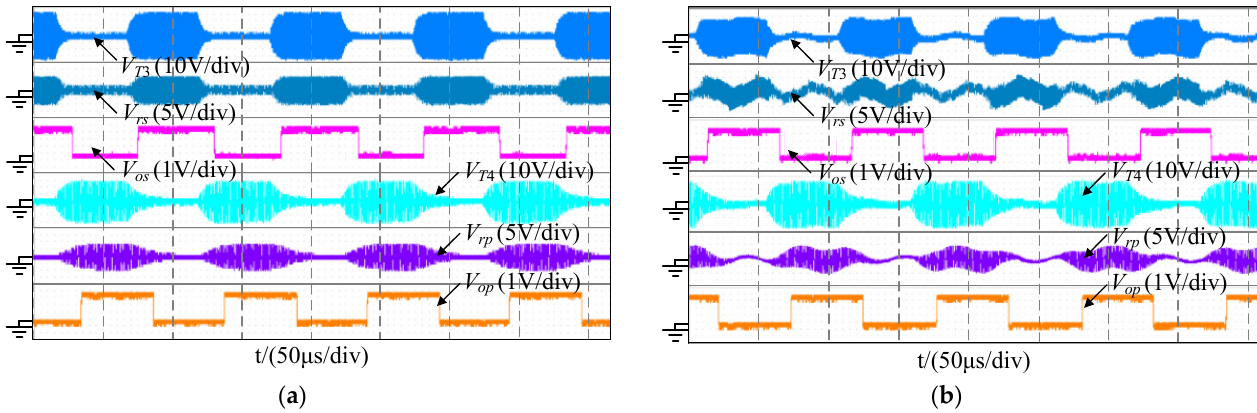
Figure 17. The full-duplex communication between the primary side and the secondary side. ( a ) Power carrier does not exist in the circuit. ( b ) Power carrier exists in the circuit.